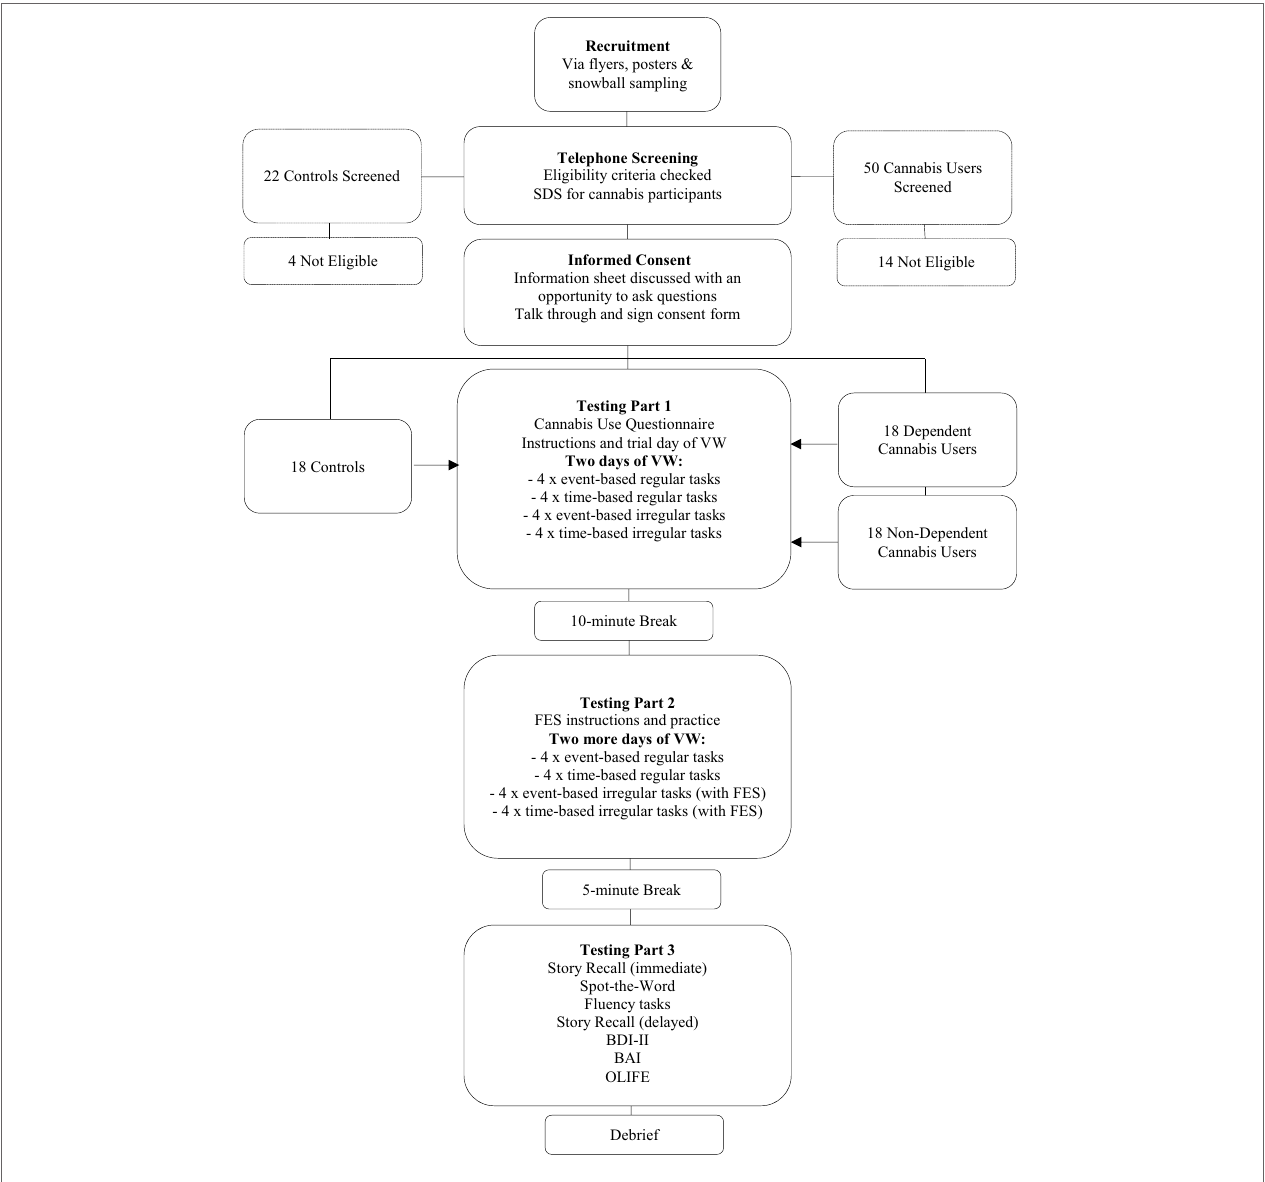
FigUre 2 | Study flow